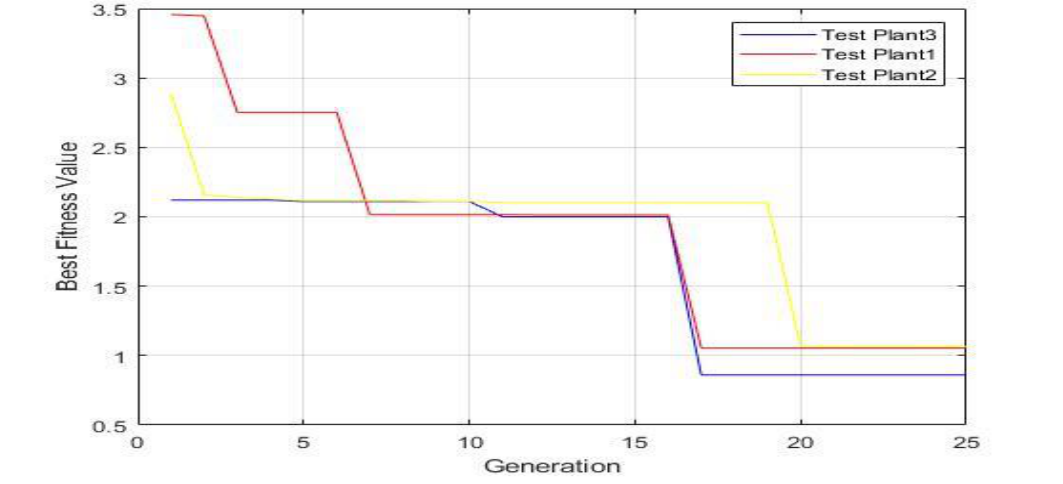
Fig. 10. Comparisons of Objective Function between Three Test Plants.